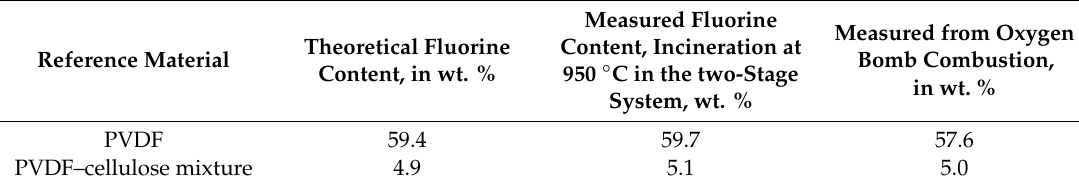
Table 5. Reference test